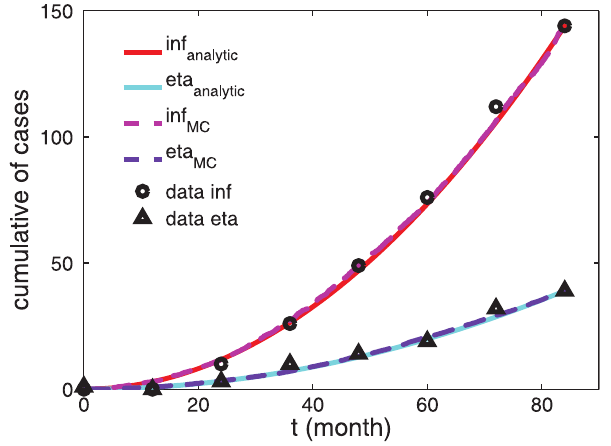
Figure 6. Comparison between experimental, analytical and numerical results for the NTM-infection case. Cumulative number of patients undergoing active NTM-infection. Experimental data from [23] ( . for infliximab-treated patients and D for etanercept-treated patients) are compared with the approximated analytical solution (see Eq. 19 , solid curves) and with data from numerical simulation (dashed curves). The parameters used to draw the analytical curves correspond to the best-fit coefficient and are reported in Table 2 . Notice that here we consider the extensive number of patients affected by NTM over the whole population of treated patients, according to experimental